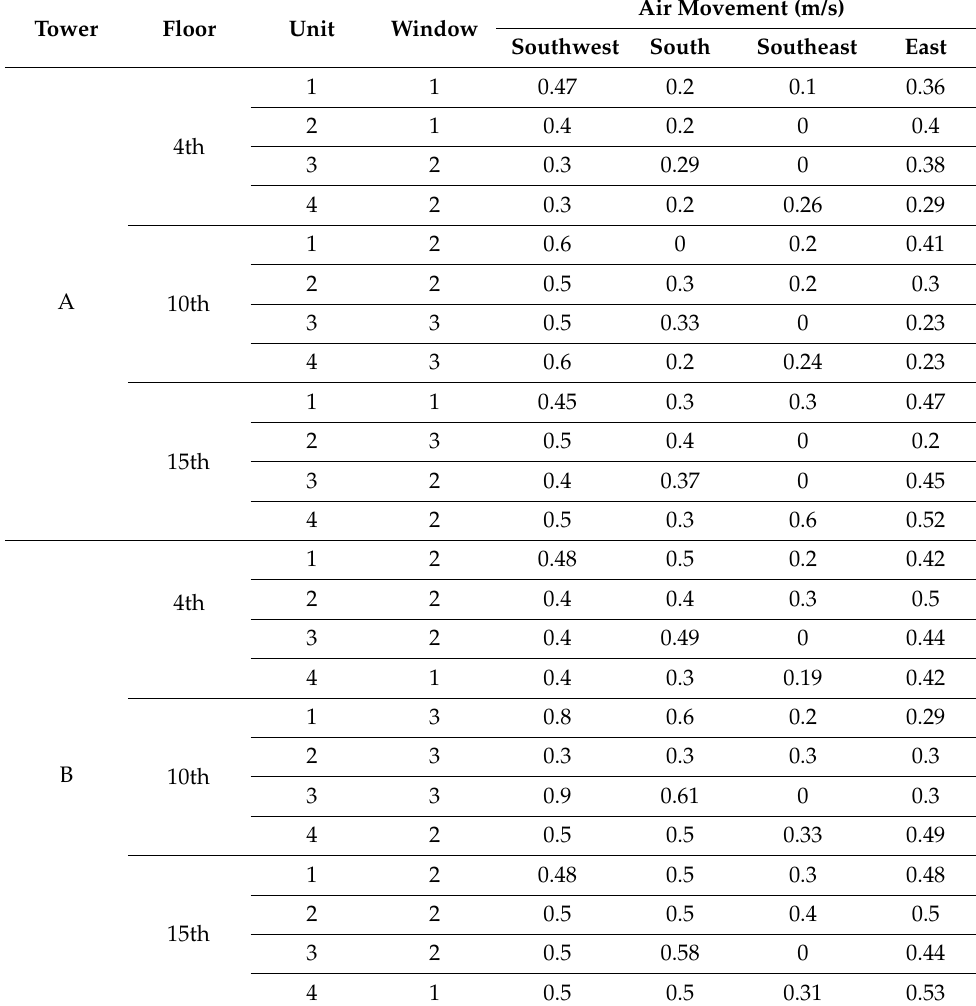
Table 13. Second-phase data interpolation: basic data.